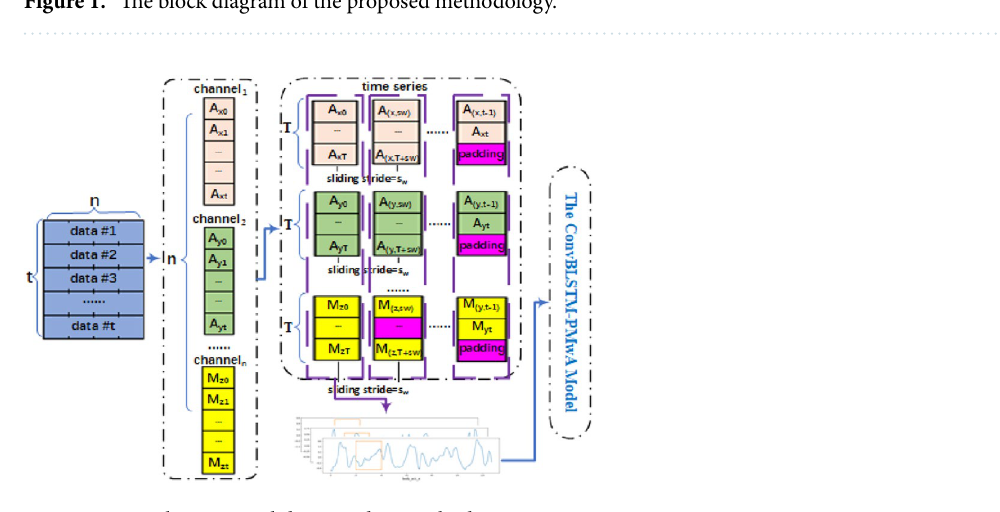
Figure 2. Equal time step sliding window